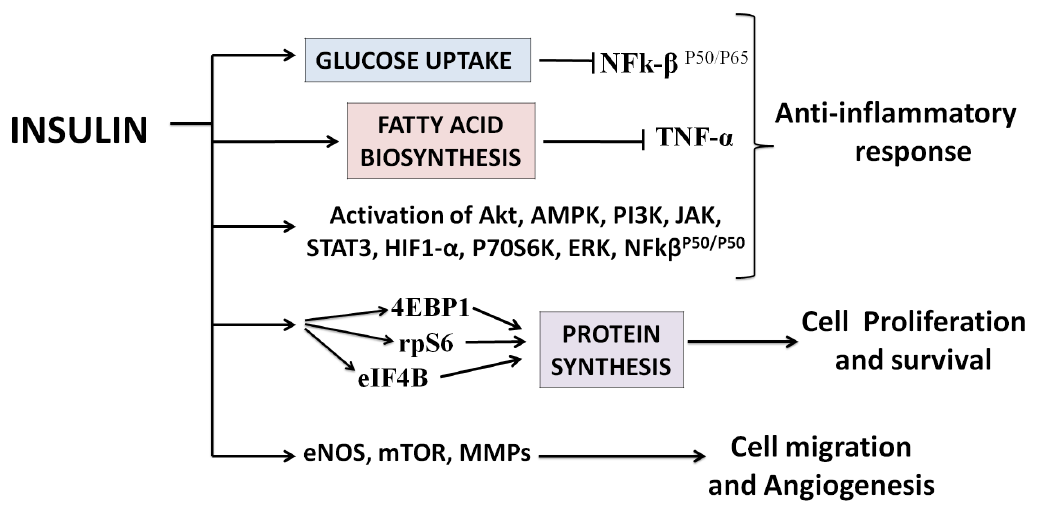
Figure 4: Insulin plays a role in anti-inflammation and cell survival through metabolic and synthesis pathways. Metabolism of glucose and fats leads to the activation of TNF-ɑ and NFk-β respectively which inactivates the inflammatory signalling. With this signalling it helps in cell survival and protein synthesis. In addition insulin can activate the Akt pathway and to increase the expression of eNOS, MMPs, mTOR leading to angiogenesis in addition to the anti-inflammatory response. Insulin can also reduce the expression of NFkβ P50/P65 through the MEK, ERK pathways such as the glucose uptake